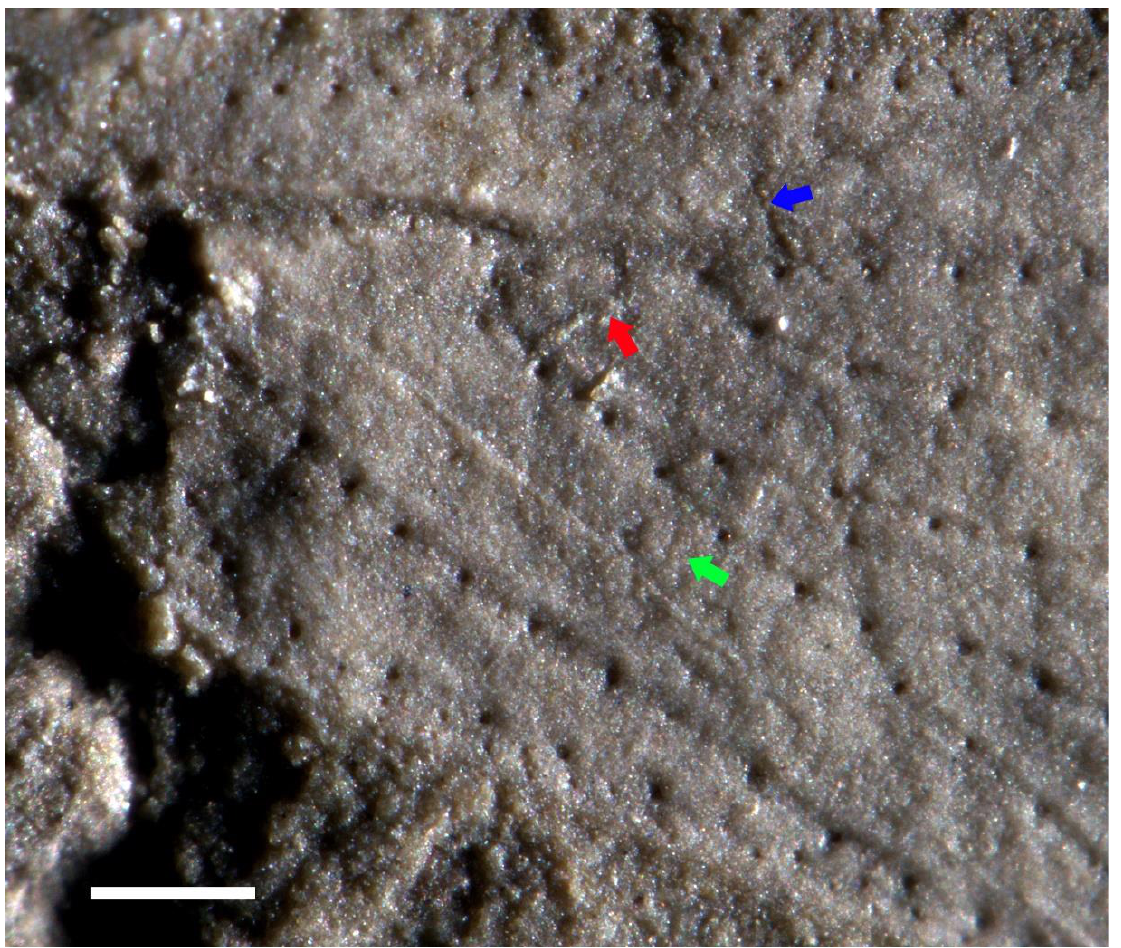
Figure 3. Triassopsyllidiida pectinata gen. et sp. nov., Middle Triassic Tongchuan biota, holotype NIGP180297, photographs of wing base, blue arrow indicating a putative crossvein between ScA and ScP+R, red arrow indicating a putative crossvein between R and M + CuA, and green arrow indicating a possible crossvein cua-cup. Scale bars: 0.2 mm.